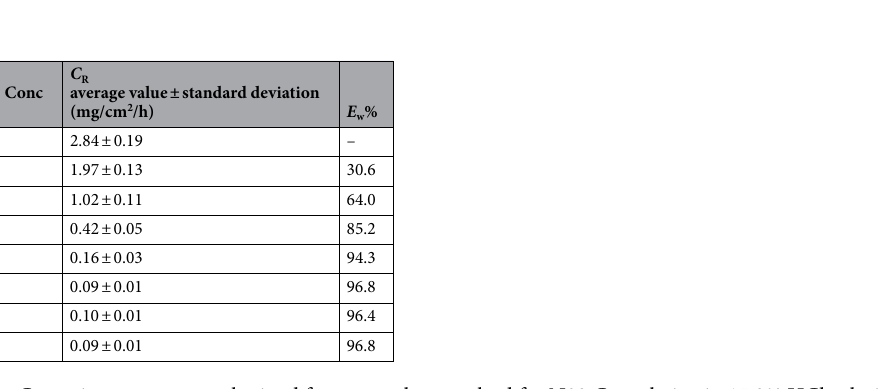
Table 1. Corrosion parameters obtained from mass loss method for N80 C-steel pipe in 15.0% HCl solution without (blank) and with DMAEB at 303 K.